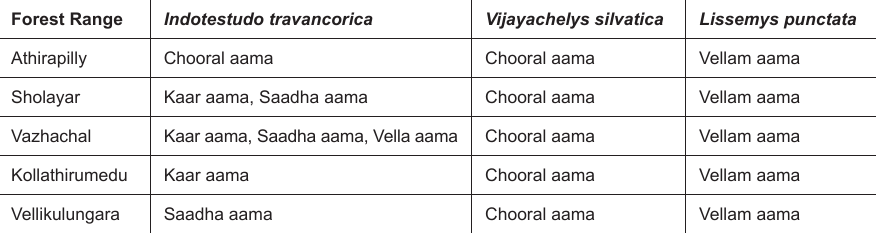
Table 1. Local (Malayalam) names used in the study area for three chelonian species Forest Range